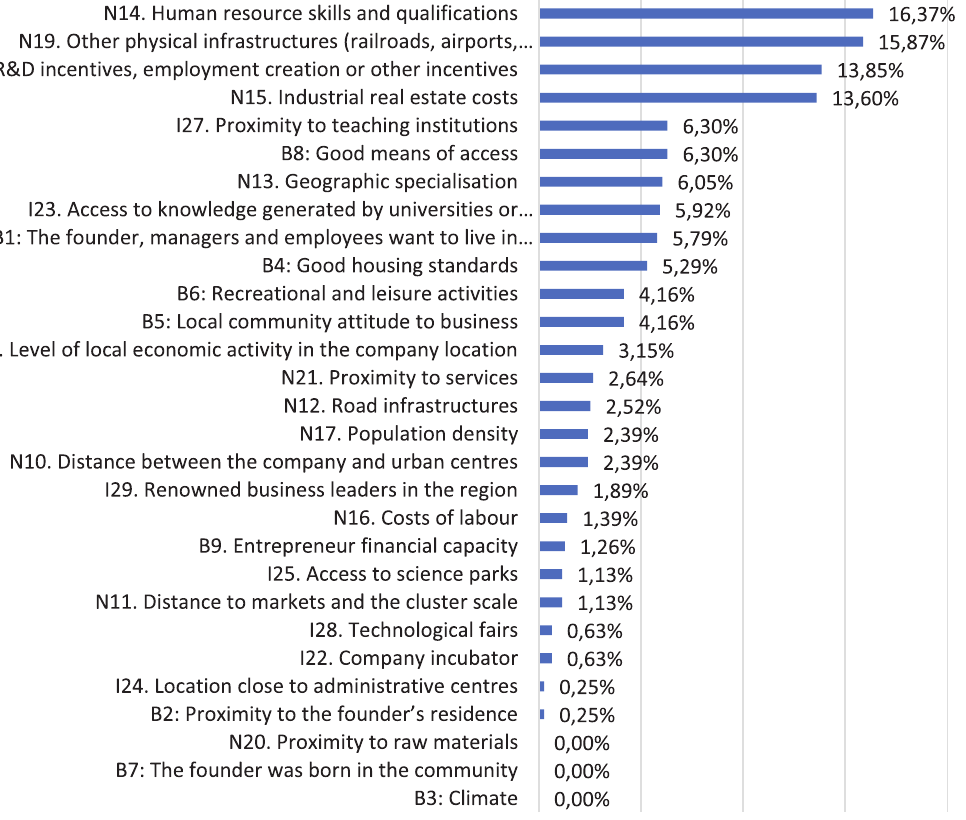
Figure 7. Location factors ranked by attribution